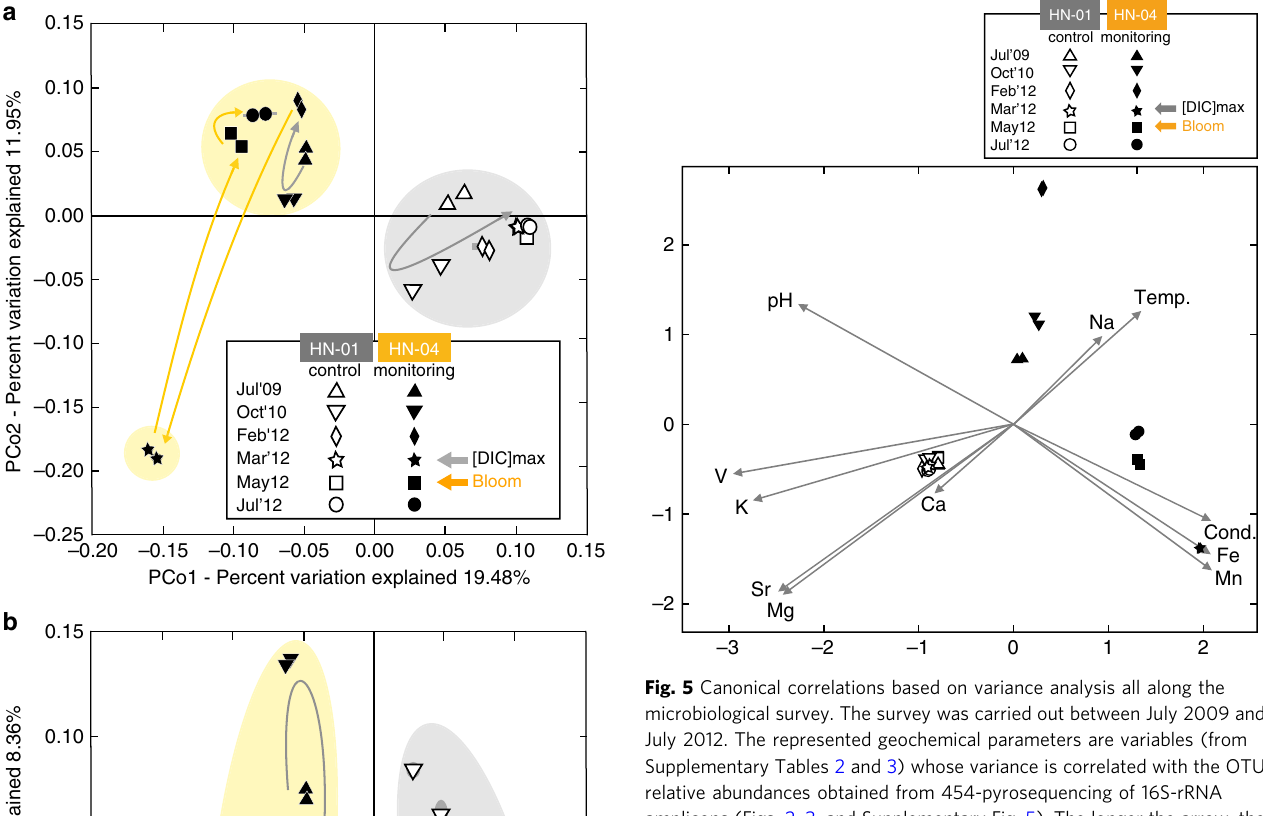
Table 7). No other CO 2 - fi xation pathways were detected.